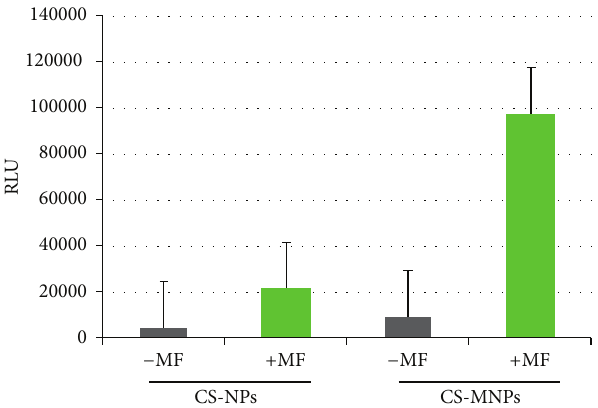
Figure 5: Determination of luciferase activity. Expression efficiency in B16F10 cells transfected with CS-NPs or CS-MPs exposed (+MF) or unexposed ( − MF) to magnetic field.